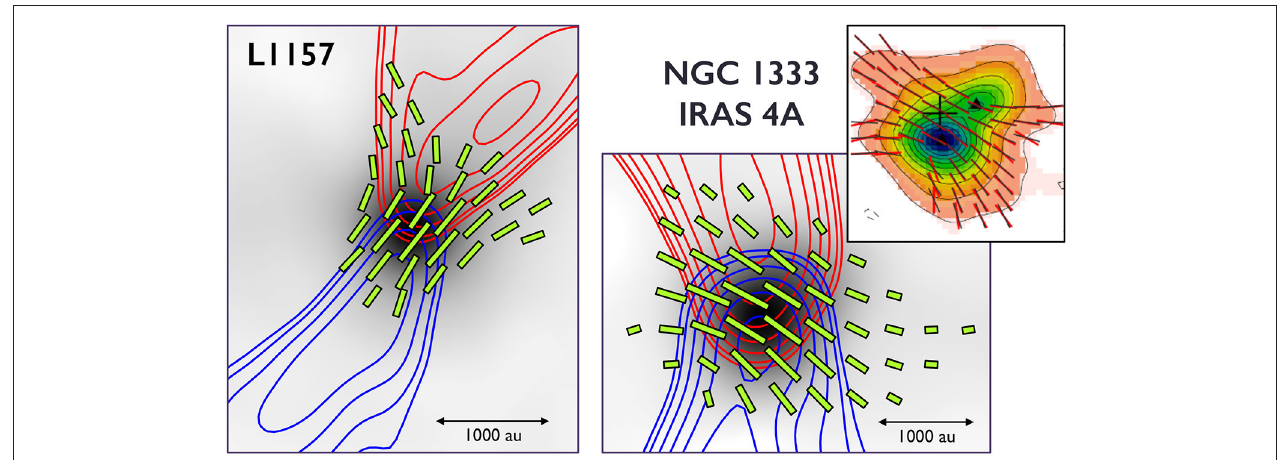
FIGURE 2 | Observations of hourglass-shaped magnetic field configurations (line segments). The rightmost, overlapping panels are NGC 1333-IRAS 4A, observed by the SMA in Girart et al. (2006, top), and again by CARMA in Hull et al. (2014, bottom/background). The SMA and CARMA observations are zoomed to the same spatial scale. The left-hand panel is the isolated Class 0 protostar L1157 (adapted from Hull et al., 2014; see also Stephens et al., 2013). Figures reproduced with permission from Science magazine and the